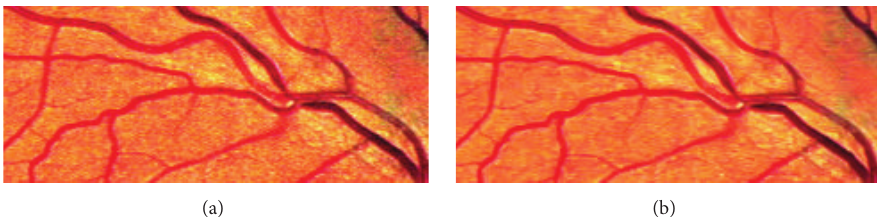
Figure 4: The subregion of Figure 3(c) (before denoising) and Figure 3(d) (after denoising). (a) Subregion of Figure 3(c); (b) subregion of Figure